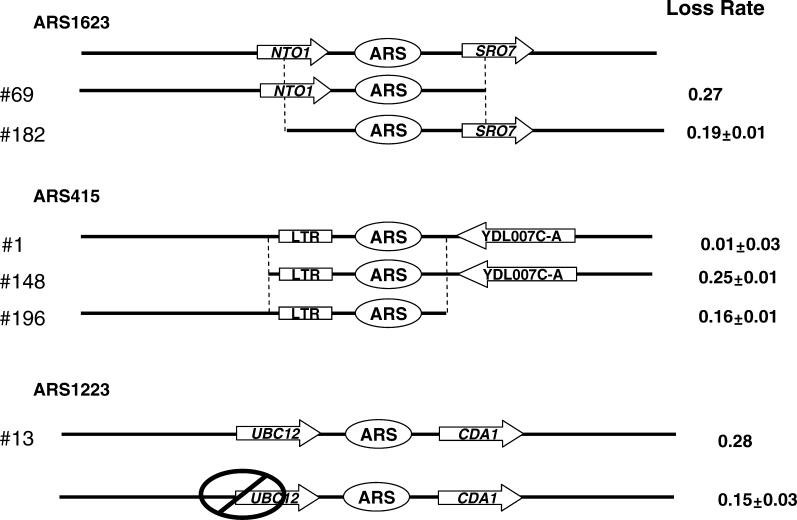
Effect of Local Transcription Pattern on Plasmid StabilityThree sets of deletion plasmid constructs and their corresponding loss rates in mcm1–1 cells are shown.